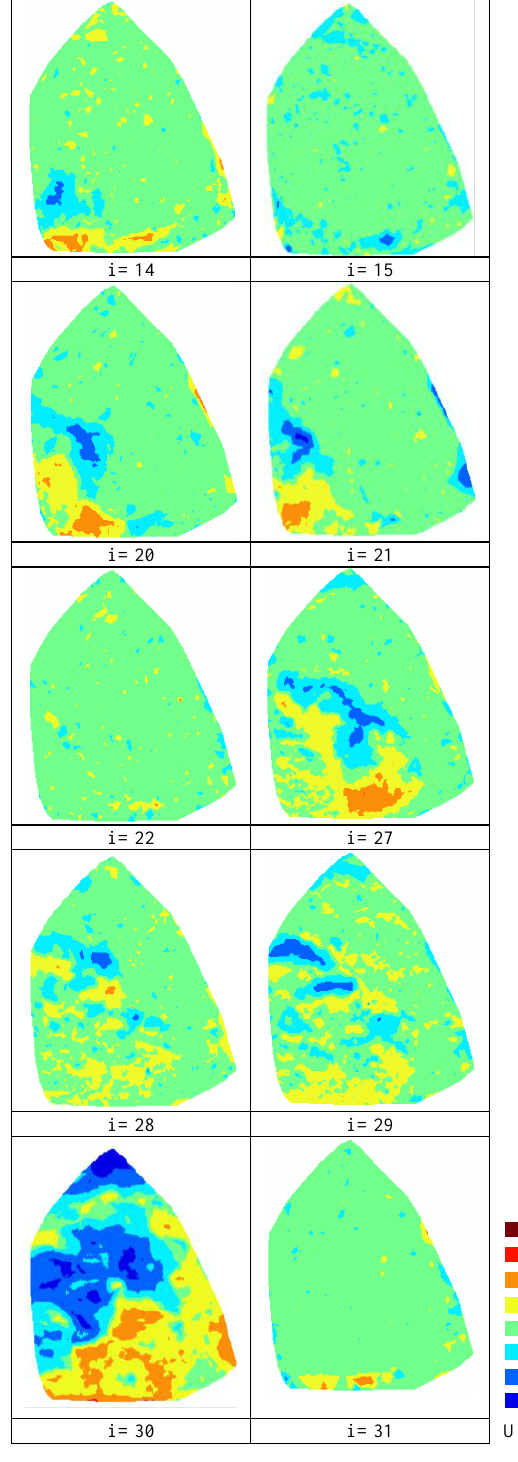
Figure 5. Landslide volumetric changes detected from the comparison of DSMs reconstructed at different epochs; here only the most representative epochs are